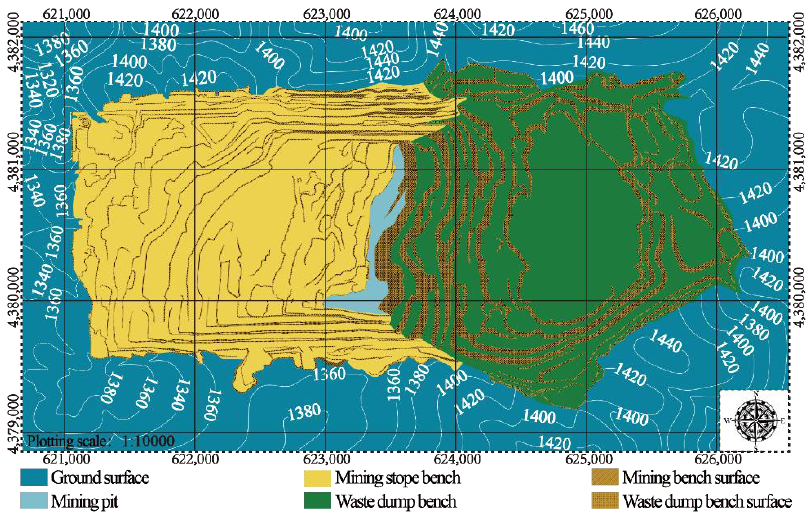
Figure 1. Location of the study area and geomorphology of the open-pit mine (the longitudinally and abscissa coordinates shown in the figure are the coordinate system).